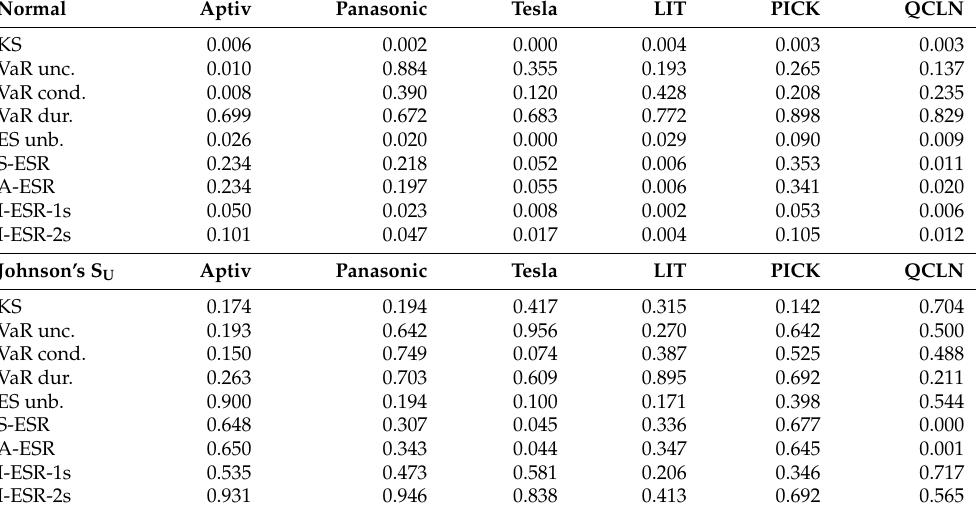
Table 2. Statistical adequacy of marginal models.